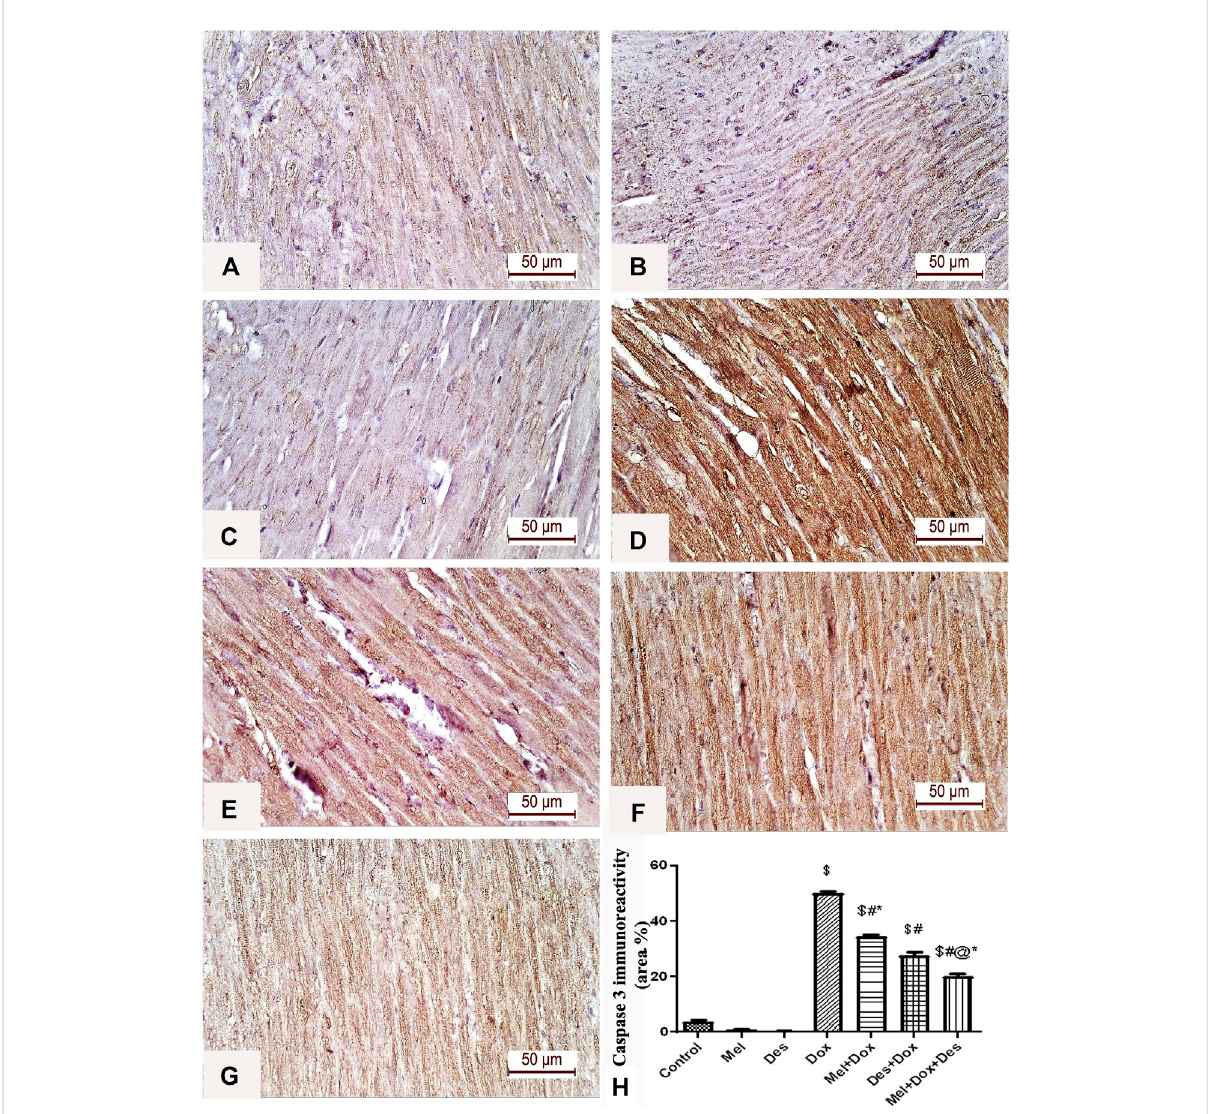
FIGURE 4 Representative fi gures of caspase-3 immunohistochemical expression in the myocardium. (A) Control group, (B) Mel, (C) Des show negative caspase-3immunoreactivityinthemyocardial fi bers. (D) Doxgroupshowsastrongpositivecaspase-3immunereactioninthecardiacmyo fi brils. (E) Mel-Dox and (F) Des-Dox show a moderate caspase-3 immune reaction in the cardiomyocytes. (G) Minimal immunoreactivity is observed in the combinedMelandDes-treatedgroup(Mel-Dox-Des)(scalebar50 µm). (H) Areapercentageofcaspase-3immunohistochemicalexpressionin the different study groups, $: signi fi cant versus control, #: signi fi cant versus Dox, @: signi fi cant versus Mel-Dox, *: signi fi cant versus Dox-Des at p < 0.05, (n = 10) using ANOVA and Tukey ’ s post hoc test for pairwise comparison. Mel: melatonin; Des: deferoxamine; Dox: